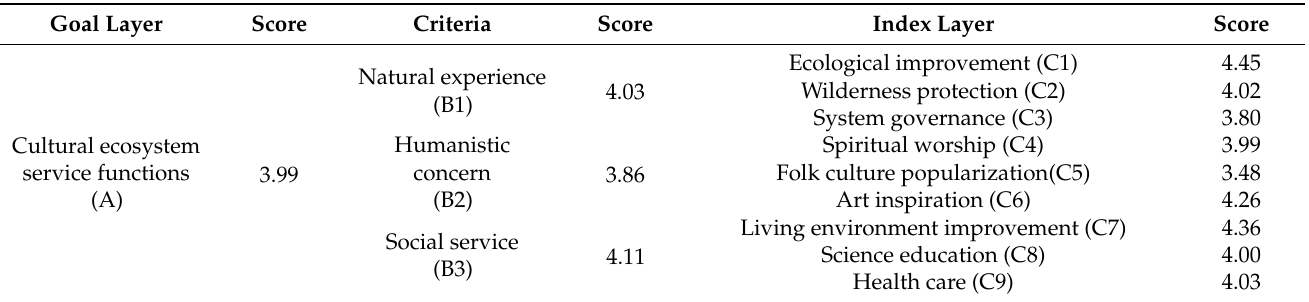
Table 7. Scores of cultural ecosystem service functions of community